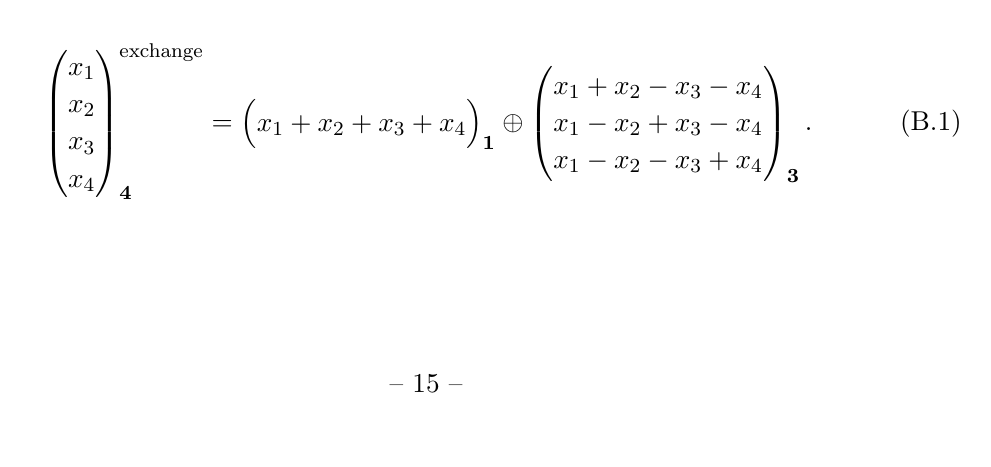
Figure 6. Proper rotations of a regular tetrahedon are isomorphic to A be s 2 = t 3 = ( st ) 3 = e . The four vertices exchange under A 4 as s : x 1 x 3 x 4 x 2 ; x 1 x 1 7! 7! 7!